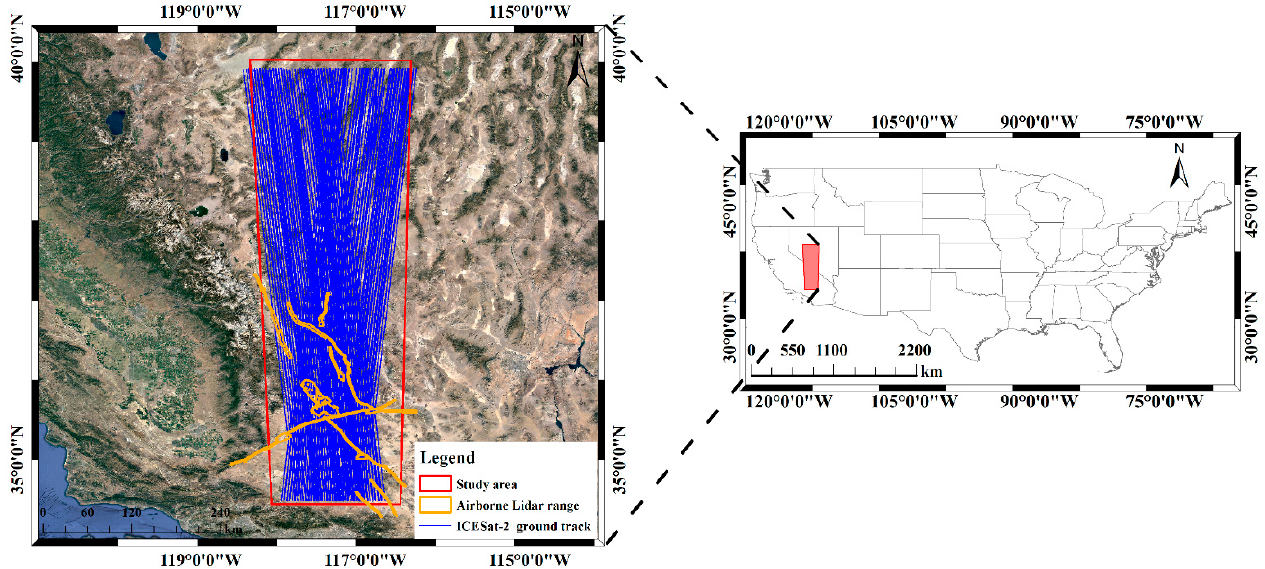
Figure 1. Overview of the study area. The right image shows the location of the study area in the United States, and the left image shows the extent of the study area, the distribution of ICESat-2 ground track and airborne lidar data.